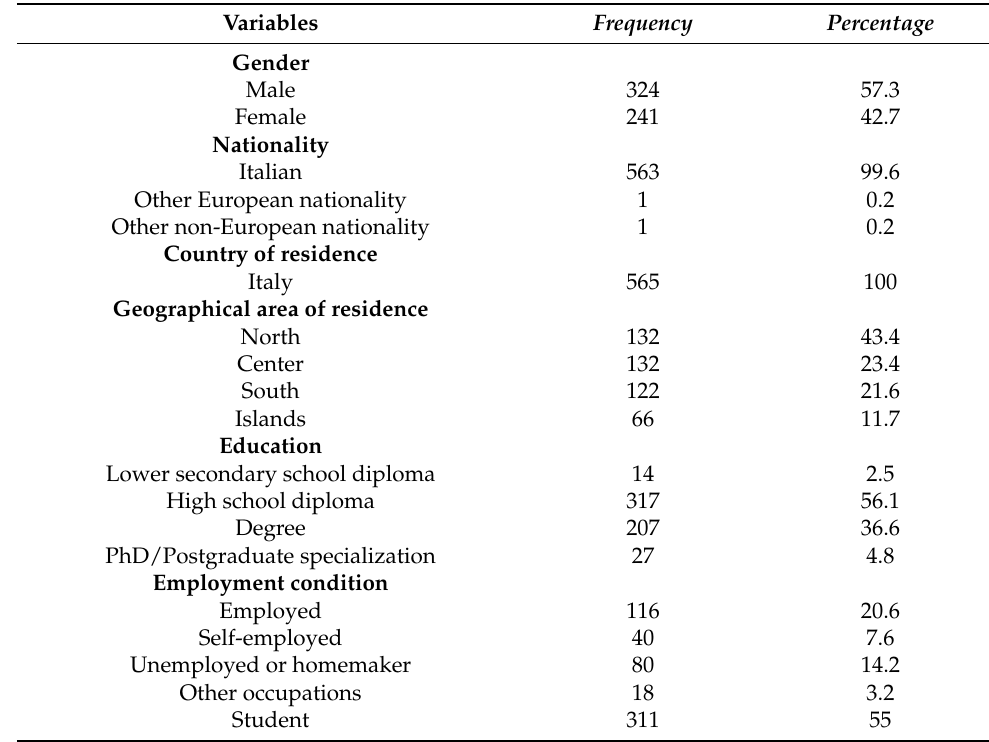
Table 1. Sample’s